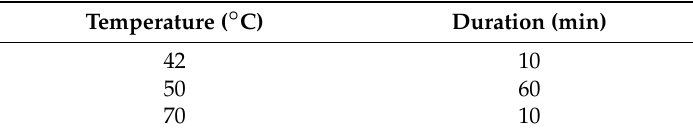
Table 1. The cDNA synthesis